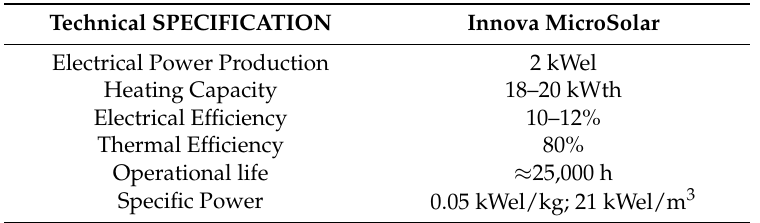
Table 3. Target specifications for the Innova MicroSolar